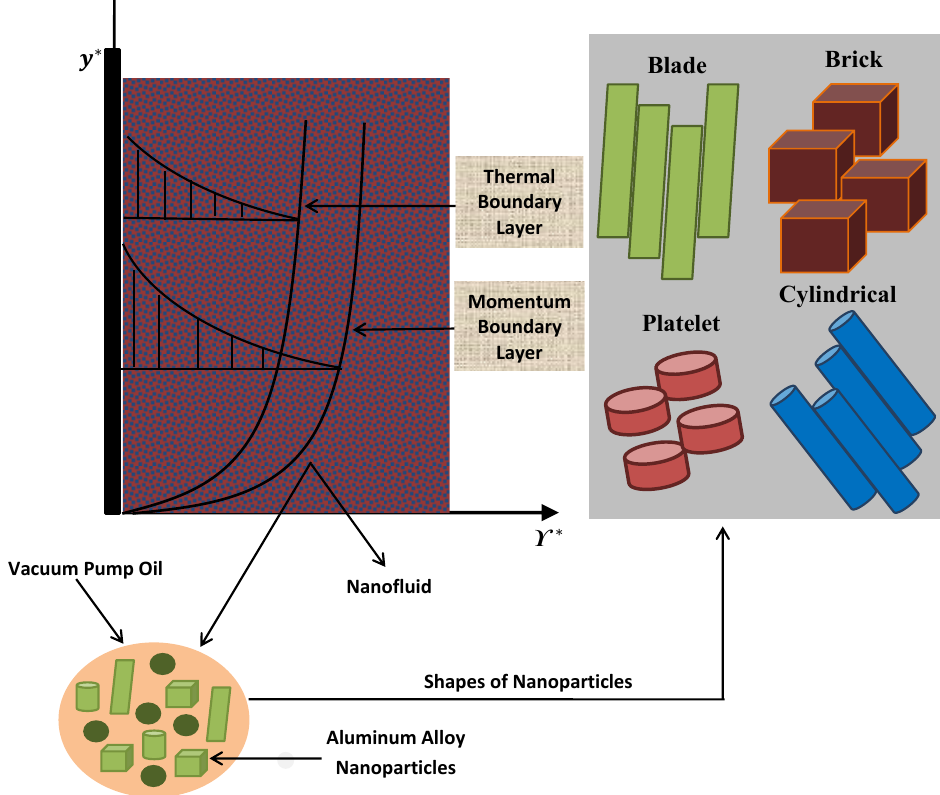
Figure 1. Geometrical arrangement of the